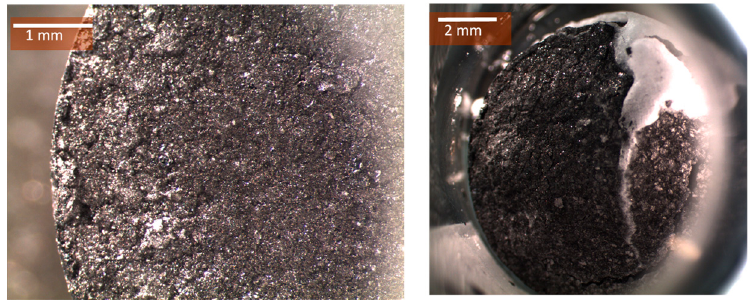
Figure 6. SBH/C (2.4) pellets before (left) and after (right) one complete dehydration (85 °C, 5% RH) and hydration (20 °C, 90% RH) cycle. The pellets were prepared under a compression pressure of 0.77 kN ⋅ mm − 2 .